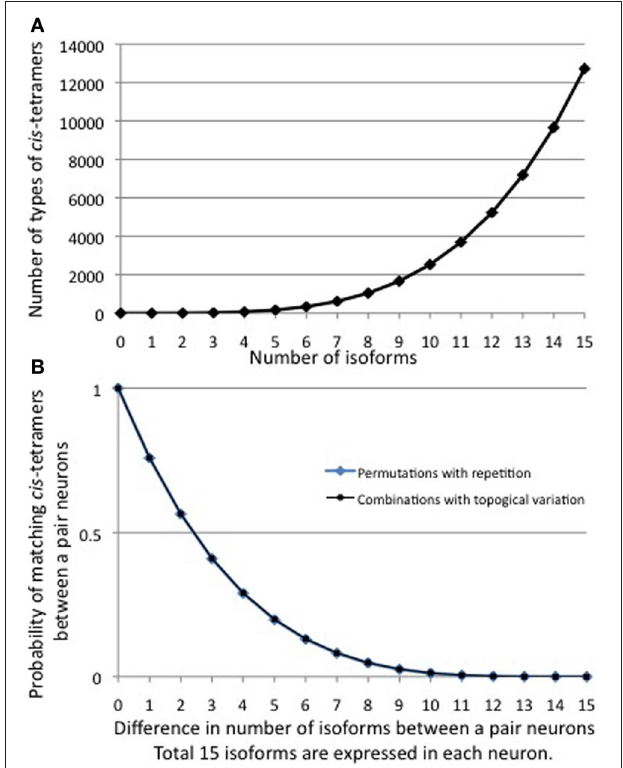
FIGURE 6 | (A) The number of combinations of heteromultimeric cis -tetramers increases as the number of isoforms increases, as a combination function. If 15isoforms are expressed in individual neurons, the number of possible cis -tetramer combinations is 12,720. (B) The probability that matching cis -tetramers will be expressed on a pair of neurons, as a function of the number of isomers that are different between the two neurons, if each neuron expresses 15isoforms. Calculations are done by two methods: combinations with topological variations (black thin line), and permutations with repetitions (blue bold line). A small number of different isoforms expressed between a pair of neurons will sharply decrease the matching probability of cis -tetramers, e.g., a difference of only 3 of a total of 15isoforms leads to 0.41 (41%) cis- tetramers matching between a pair neurons. However, 10 differences in a total of 15isoforms (5isoforms in common between a pair of neurons) yields a score of 0.013, meaning that only 1.3% of the cis -tetramers match between the pair of